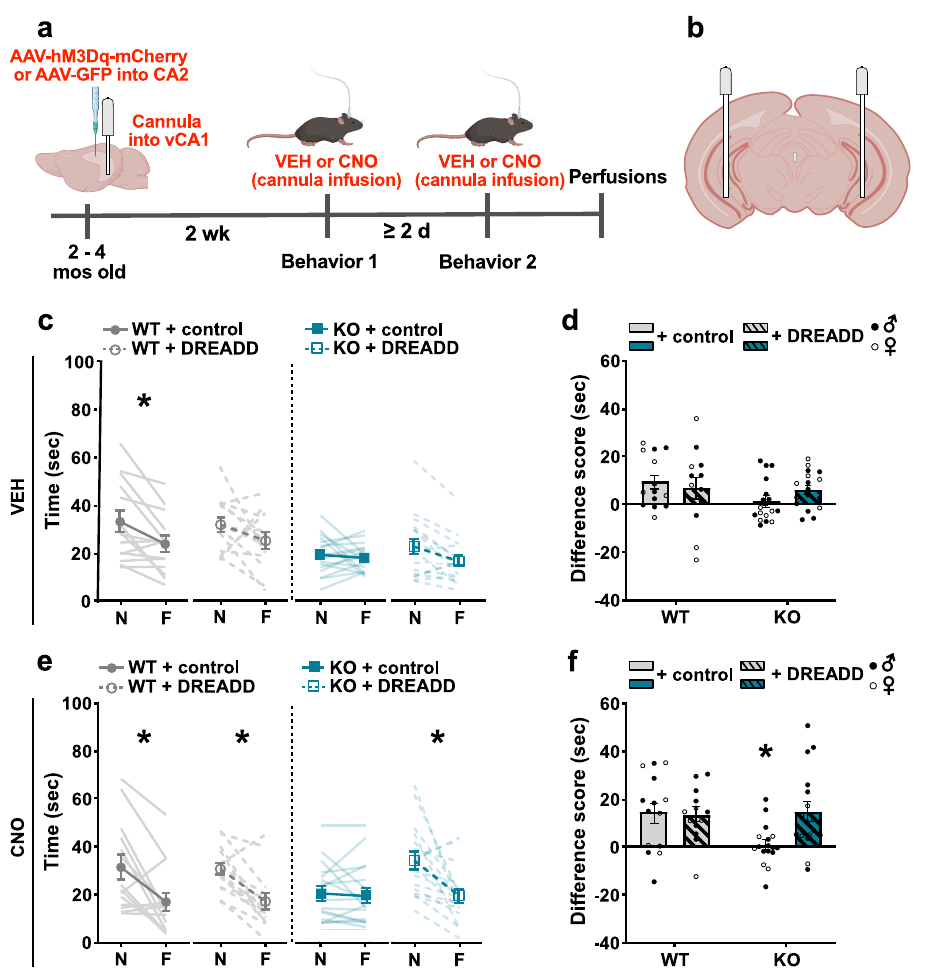
Fig. 3 | Chemogenetic activation of CA2 excitatory neurons projecting to the vCA1 improved social discrimination in Shank3B KO mice. a Timeline for experiment. b Schematic of the cannula placement sites in vCA1. c Following VEH infusions into the vCA1,virus-infected KO mice showedno signi fi cant differencein interactiontimesbetweennovelmice(N)andfamiliarmice(F),whilecontrolvirus- orDREADDvirus-infectedWTmiceshowedadecreaseininteractiontimesbetween N and F, although the difference in WT+DREADD virus was not statistically sig- ni fi cant(WT+controlvirus, p =0.0270;WT+DREADDvirus, p =0.3529).Therewas no effect of virus group (see Table S1). d Following VEH infusions into the vCA1, both WT virus groups had greater difference scores (N minus F) than KO virus groups, although these comparisons were not statistically signi fi cant ( c, d , n =14 for WT+control virus, n =13 for WT+DREADD virus, n =17 for KO+control virus, n =17forKO+DREADDvirus).SeeTableS1forcompletestatistics. e FollowingCNO infusions into vCA1, WT virus groups and DREADD virus-injected KO mice had